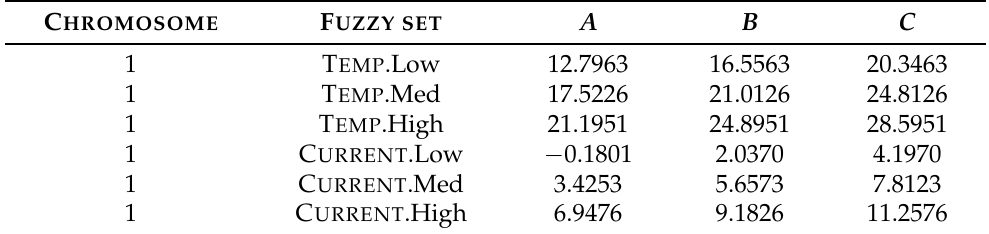
Table 5. The membership functions of the initial population elements. The triangular membership functions are represented by three dimensional vectors (see Figure